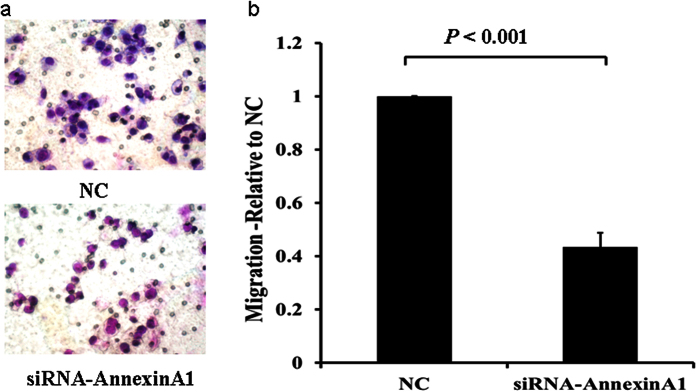
Knockdown of Annexin A1 by siRNA inhibits AGS cell migration.Migration assay was conducted with Annexin A1 siRNA or NC transfected AGS cells using 24-well Transwell chambers. (a) Representative images of migrated cells in NC and siRNA transfected cells. (b) Cell migration was assessed by counting the number of AGS cells that migrated through the transwell insert by light microscopy on 3 independent membranes, then normalized against the NC treated cells to determine the relative ratio.